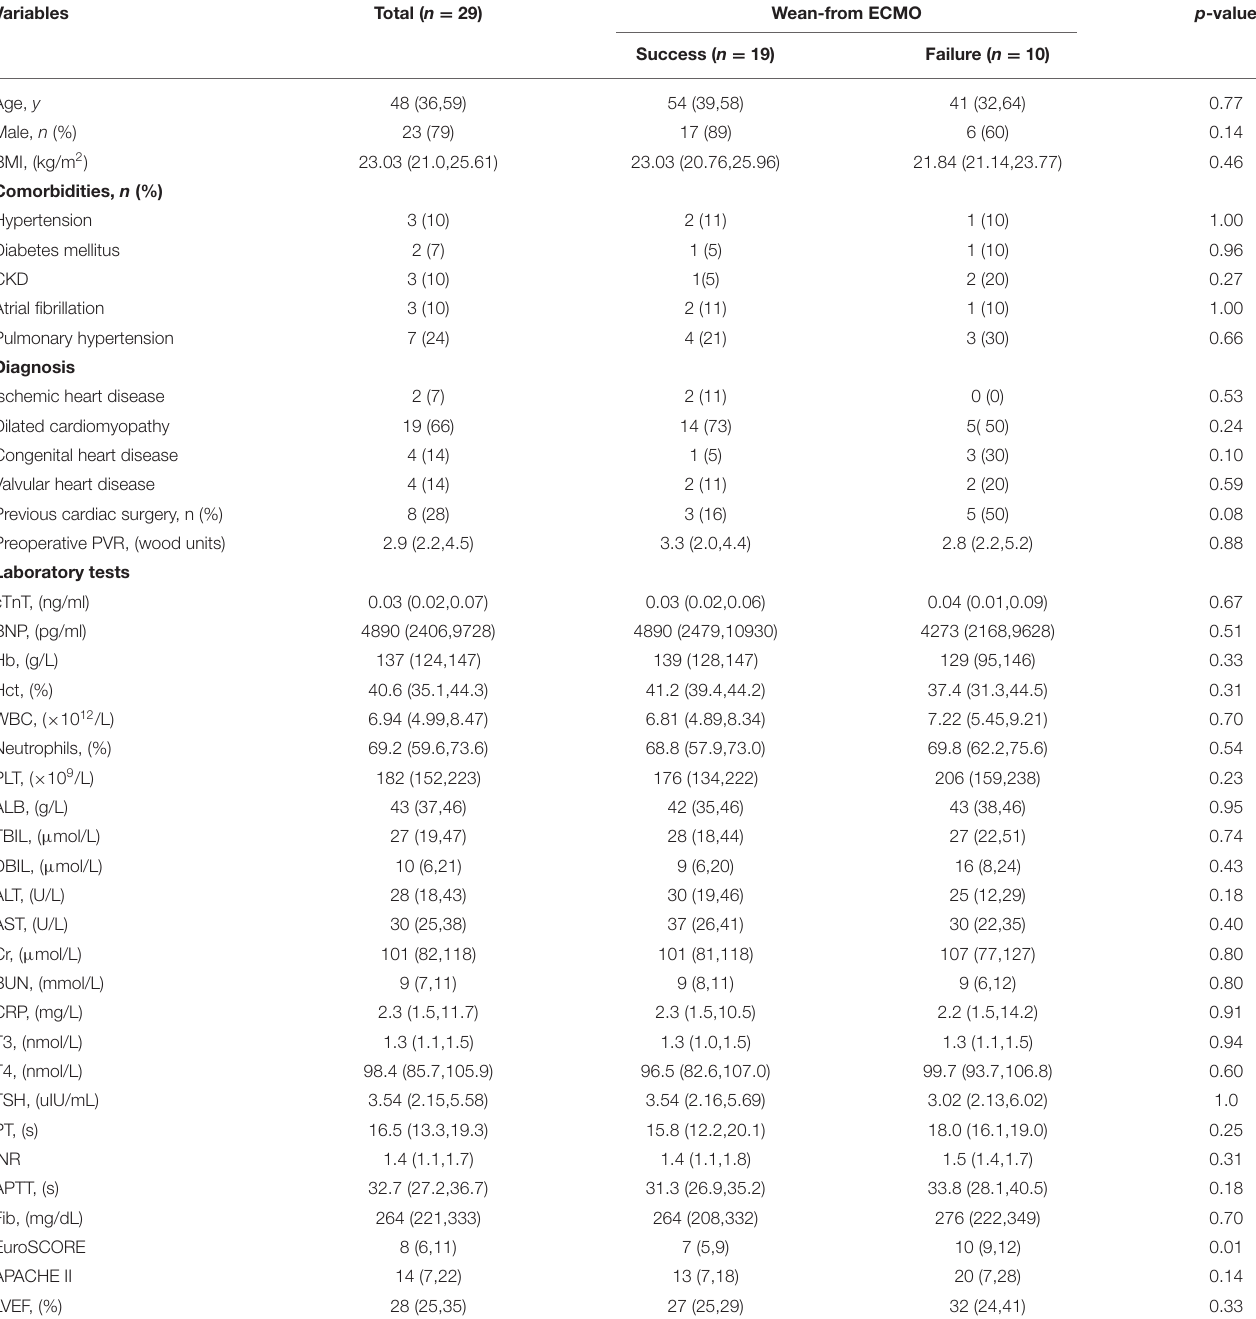
TABLE 1 | Demographic and clinical characteristics of ECMO patients prior to surgery.